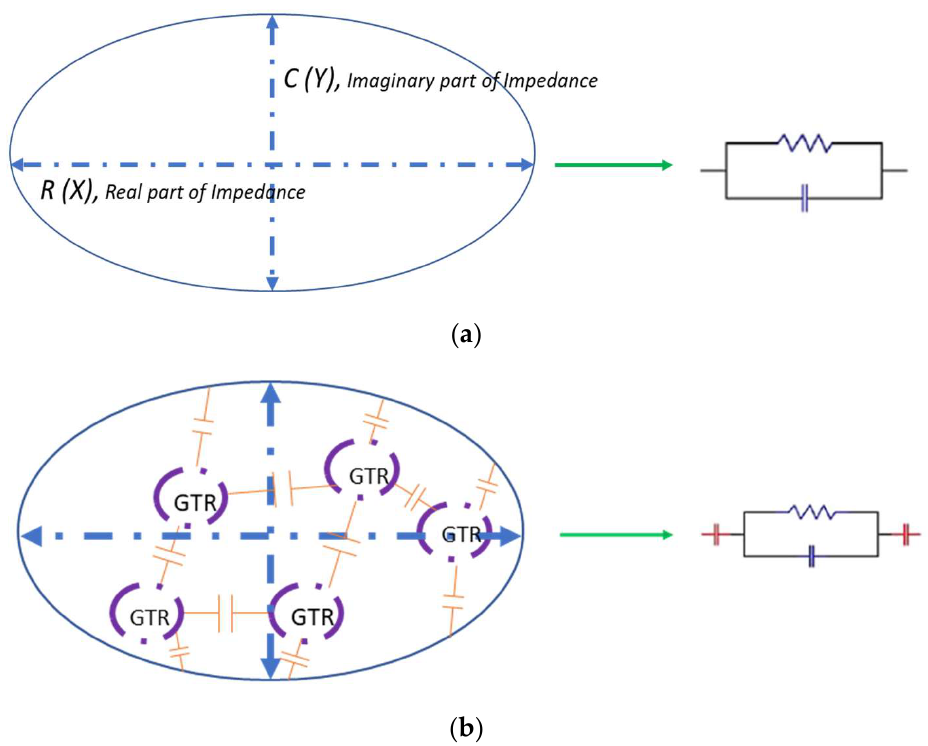
Figure 10. Schematic representation of the dielectric structure and effects-model: ( a ) of LDPE–HDPE neat and ( b ) LDPE composites with GTR reinforcement.